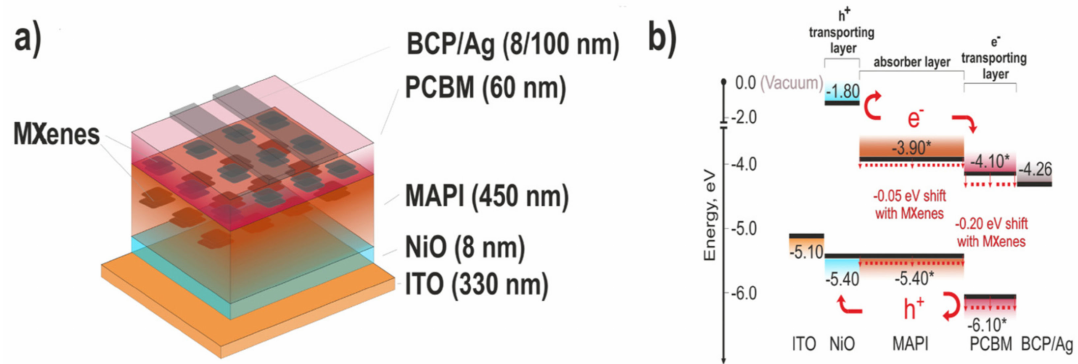
Figure 6. ( a ) Schematic representation of MXene-based p-i-n PSCs ( b ) energy level diagram for a PSC. Reprinted with permission from Ref. [78]. Copyright 2021 Elsevier Ltd. All rights